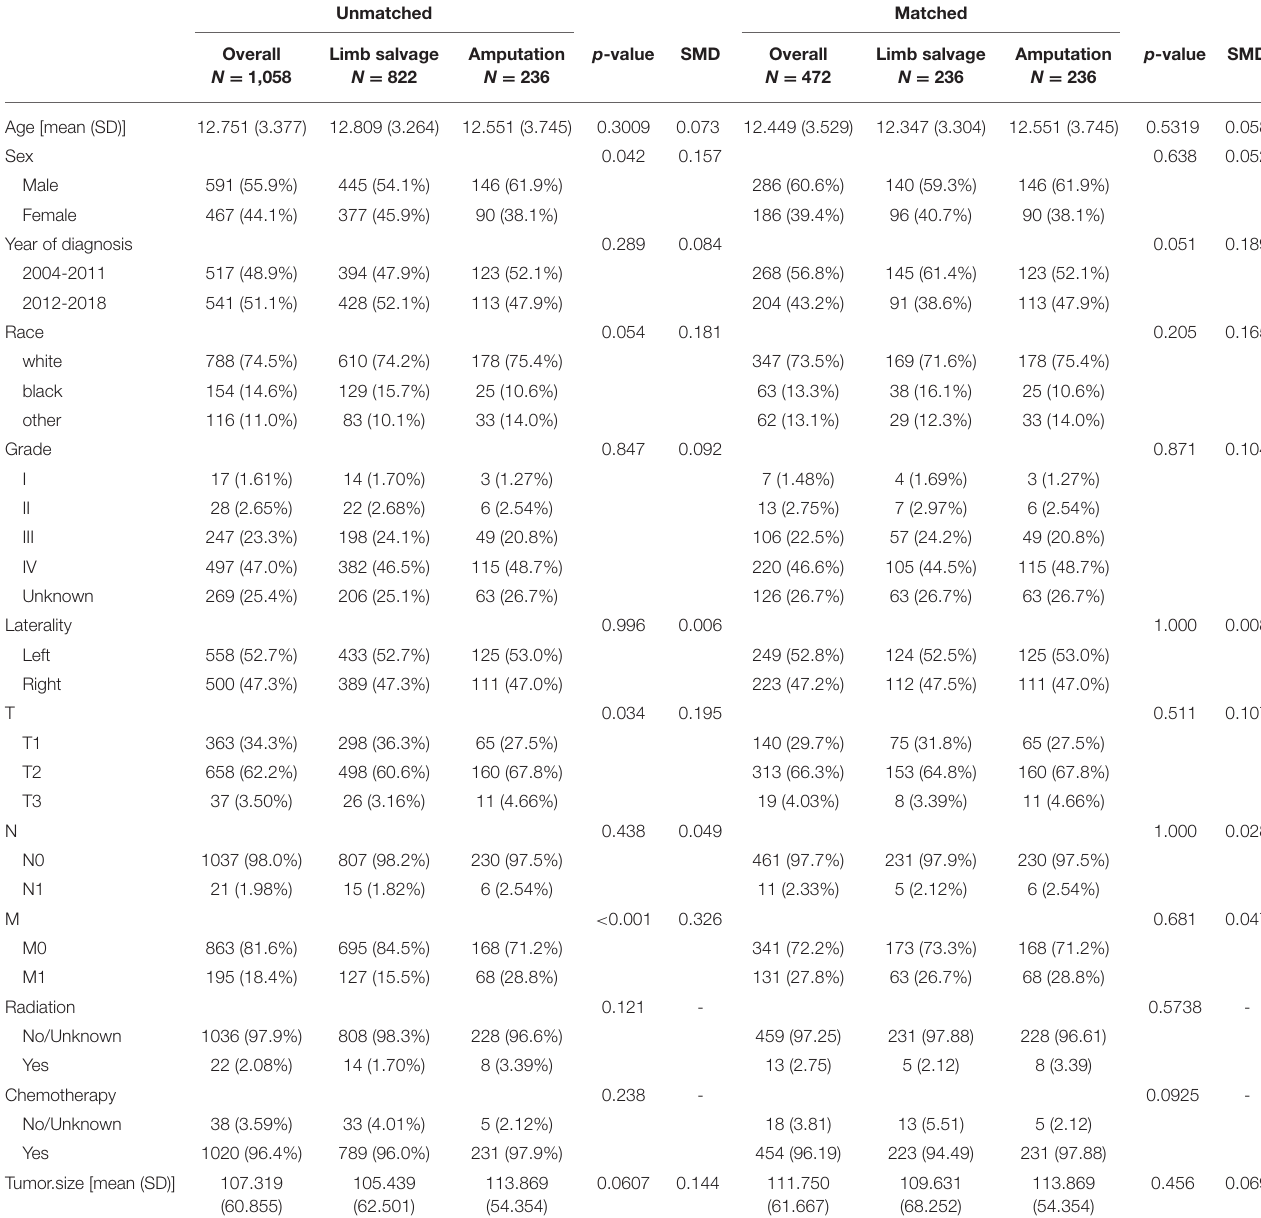
TABLE 1 | Sociodemographic and clinical characteristics of patients receiving limb salvage vs. amputation in pediatric osteosarcoma patients.